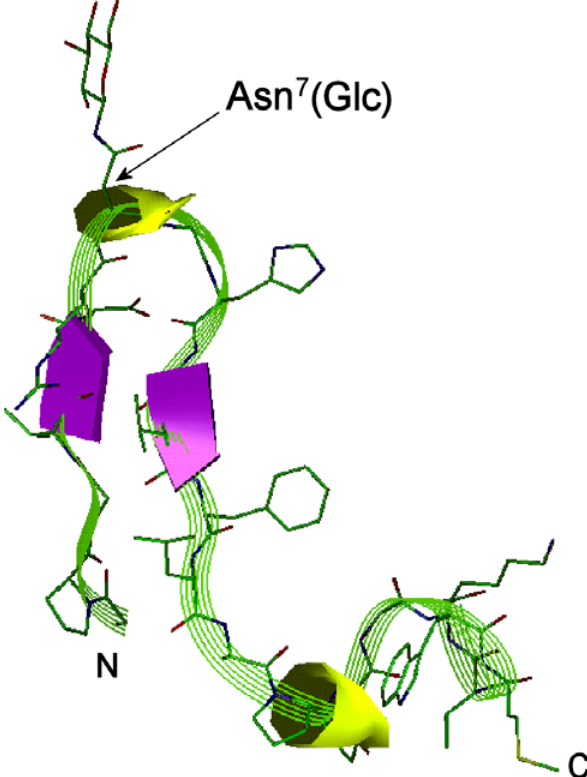
Figure 2. The β-turn peptide structure exposing at position 7 the N-glucosylation recognizing specific antibodies in Rett syndrome in a home-made ELISA.